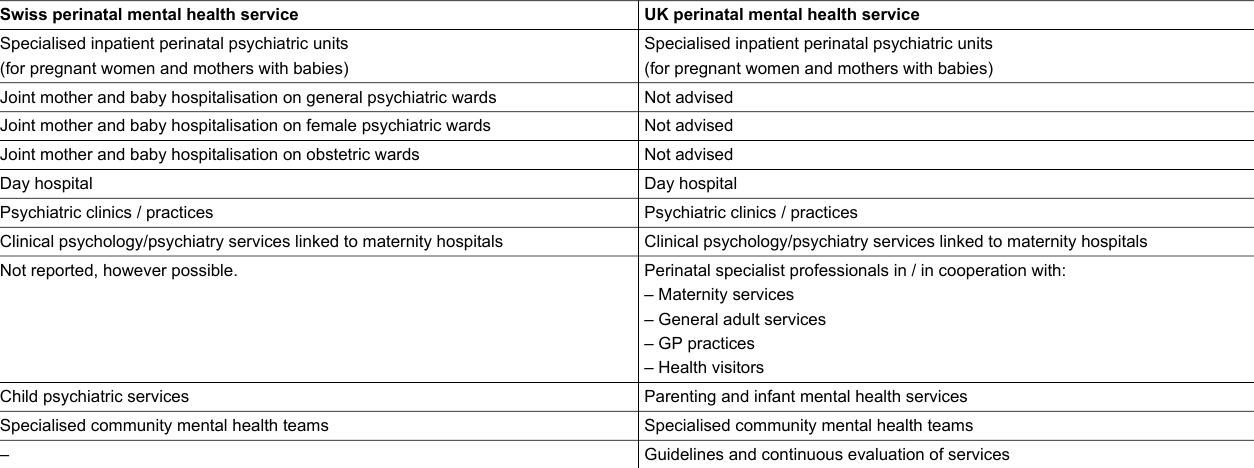
Table 2: Perinatal mental health service structure in all levels of care in the UK and in Switzerland. Swiss perinatal mental health service Specialised inpatient perinatal psychiatric units (for pregnant women and mothers with